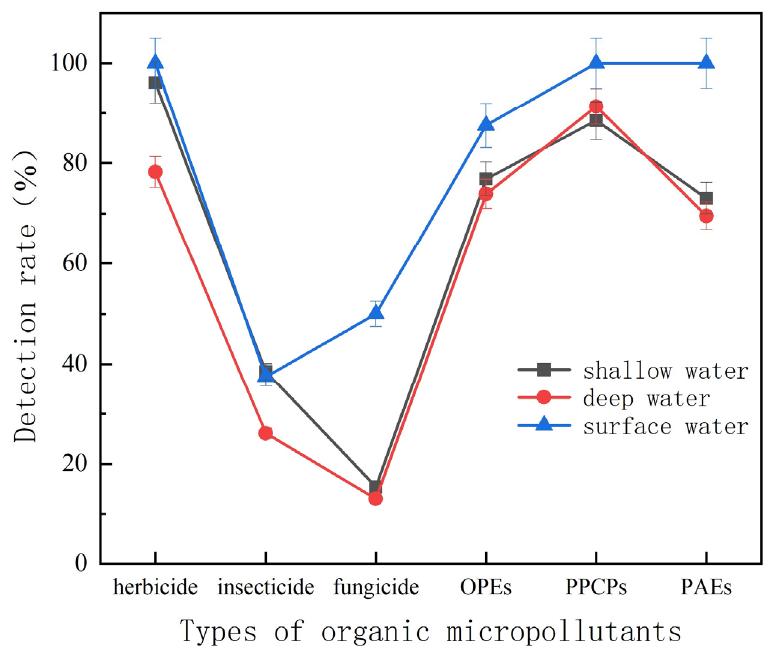
Figure 13. Detection of organic micropollutants in different water sources.